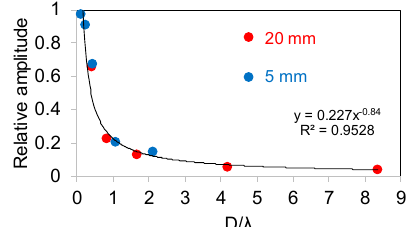
Figure 9. Relative amplitude vs. sensor size over wavelength parameter ( D / λ ).